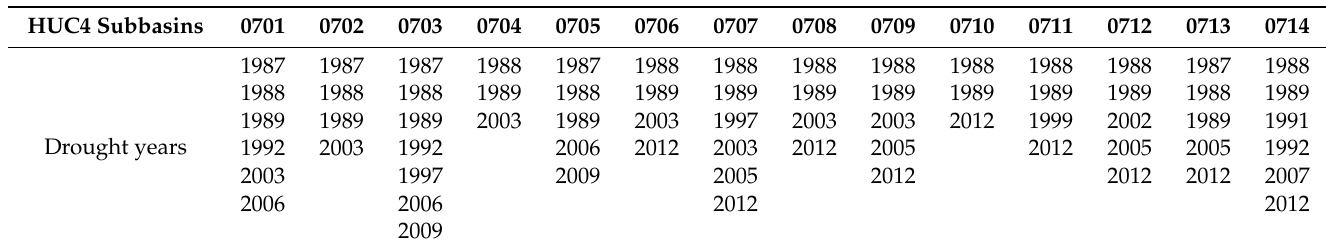
Table 3. Major drought years for each of the HUC4 subbasins identified using the 12-month standardized precipitation index ( SPI12 ), the 12-month standardized streamflow index ( SSI12 ), and the 12-month standardized soil water content index ( SSWI12 ) for the period 1985–2014.